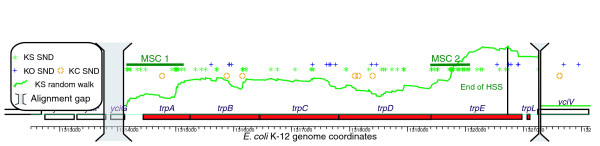
The KS local random walk plot showing homologous recombination in the tryptophan (trp) operon. Genes are rectangular boxes positioned above or below the axis based on transcribed strand. KS SNDs form two non-overlapping MSCs with significant local scores exceeding 170. Both MSCs, with a combined length under 2 kb, are contained in a single 6.5 kb HSS covering most the trp operon. The positions of each KO, KC, and KS SND in E. coli K-12 are shown above the KS excursion. Random walk values below 50 are not plotted, resulting in the absence of visible KC or KO excursions.